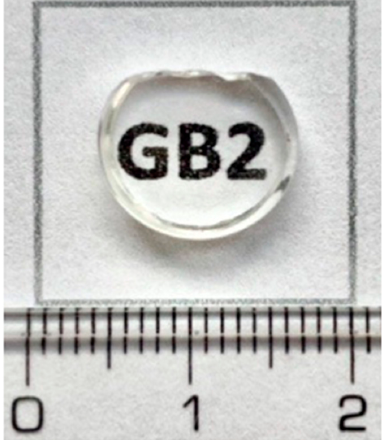
Figure 1. Photographs of the obtained glass sample: 30GeO 2 ‐ 30TiO 2 ‐ 30BaO ‐ 10Ga 2 O 3 (GT2).